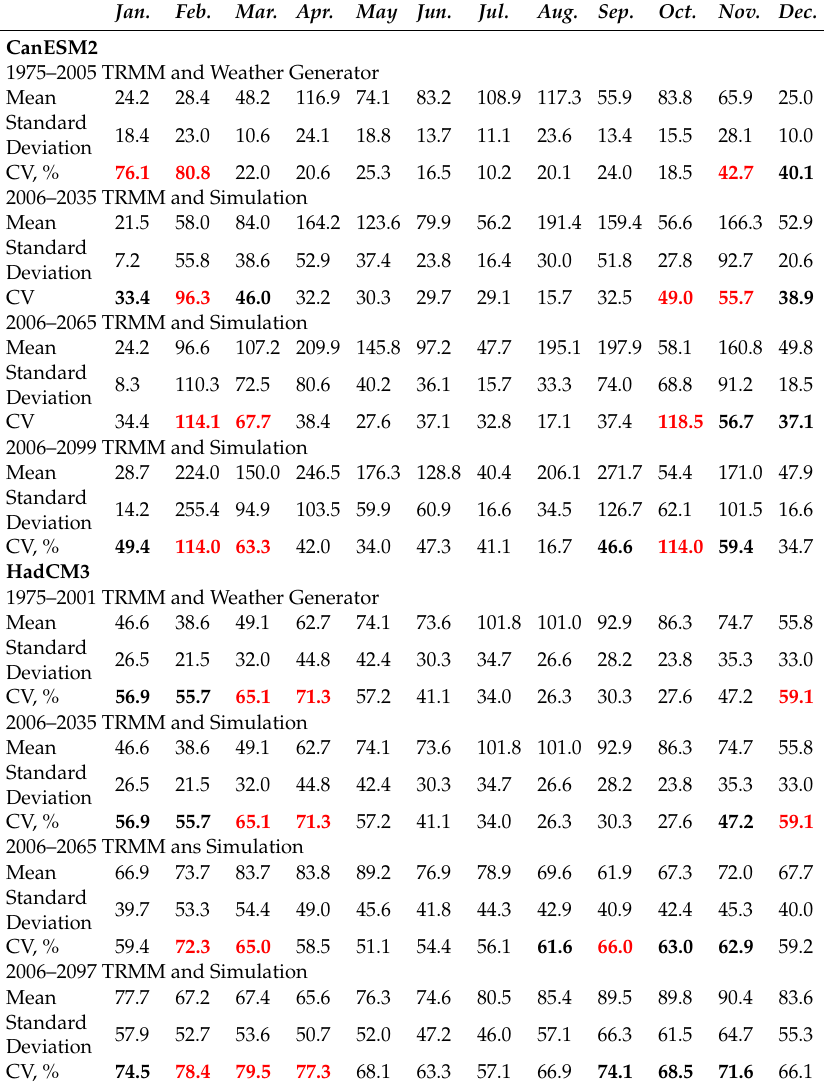
Table 6. Agoro TRMM and Simulated (CanESM2and Had3) Monthly Rainfall Coe ffi cient of Variation.